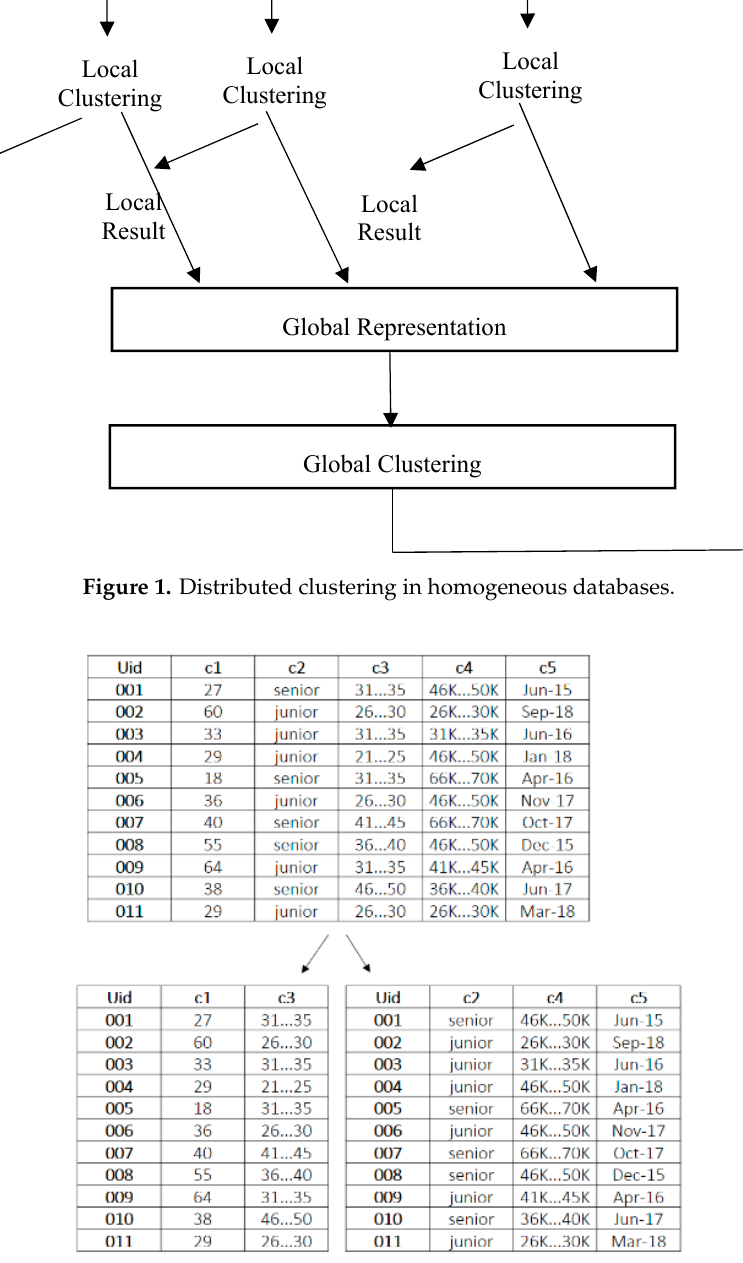
Figure 2. An example of a heterogeneous dataset.